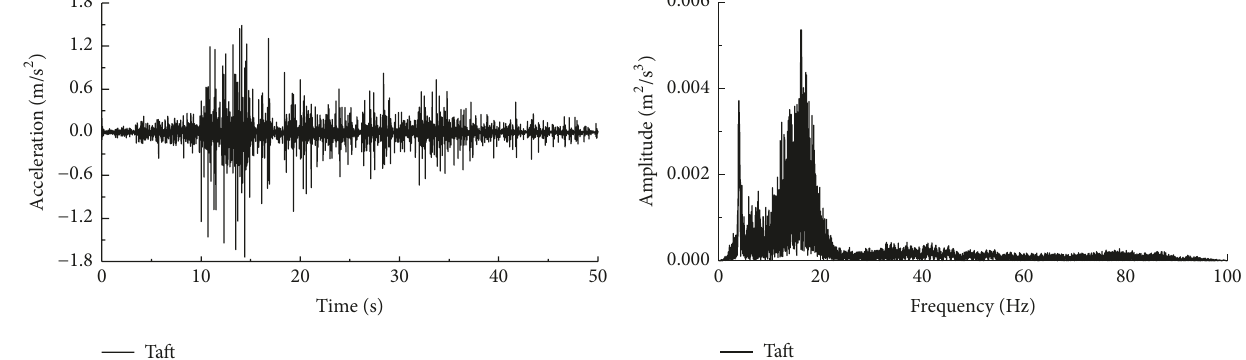
Figure 24: Vertical acceleration time history and Fourier spectrum curves at node 103 under Taft wave.